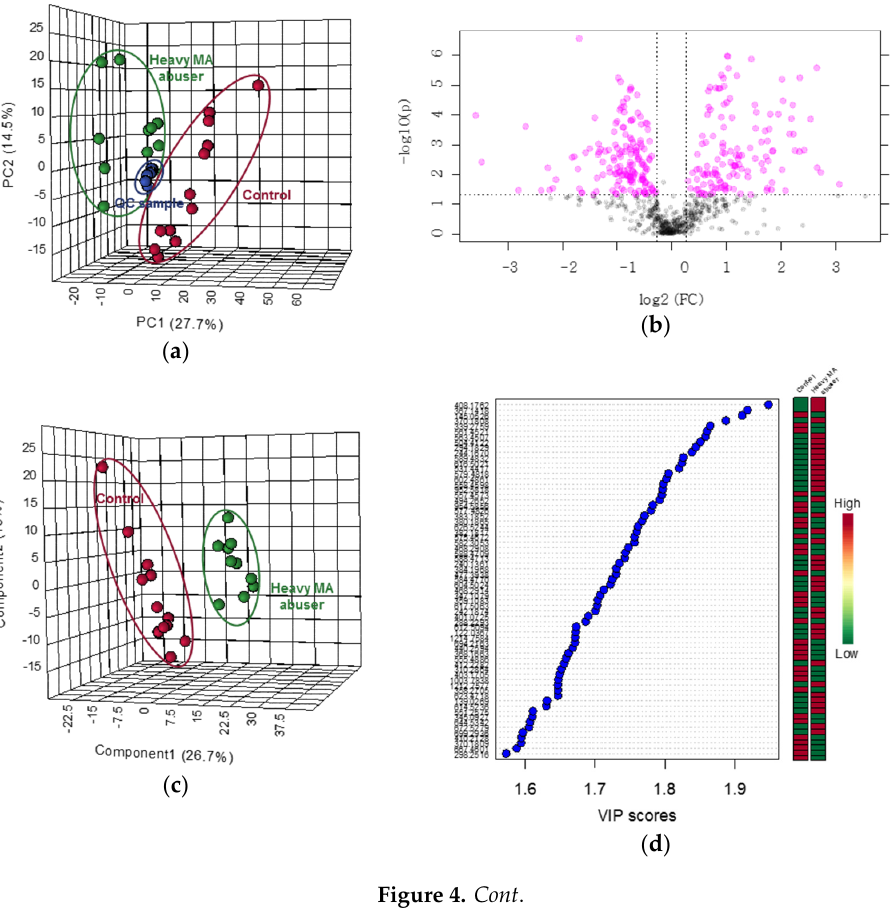
Figure 3. Statistical results of untargeted metabolomics by the positive ionization mode of ultra-high-performance liquid chromatography coupled to quadrupole time-of-flight electrospray ionization mass spectrometry (UPLC-QTOF-ESI-MS) in hair samples from drug-free controls ( n = 12) and heavy MA abusers ( n = 10). ( a ) Principal component analysis (PCA) score plot. Red circle: drug-free controls; green circle: heavy MA abusers. ( b ) Volcano plot. Red circle: metabolites with significance at p < 0.05 and fold change > 1.2 or < − 1.2: + ND: increased from the value of not detected. ( c ) Partial least squares discriminant analysis (PLS-DA) score plot. Red circle: drug-free controls; green circle: heavy MA abusers. ( d ) Variable importance on projection (VIP) score plot. Colored box: relative concentration in drug-free controls and heavy MA abusers; ( e ) Venn diagram integrating results from the t -test, VIP scores, and receiver-operator characteristic (ROC) curve.